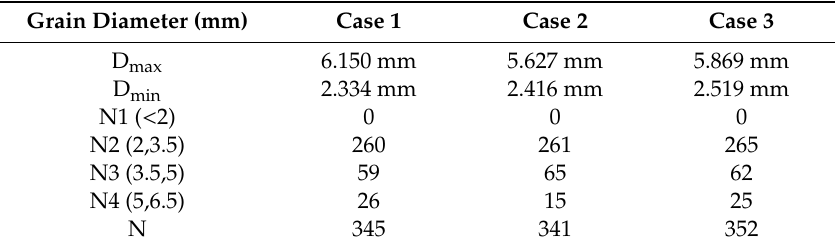
Table 3. Grain size of aggregates in Section 3.